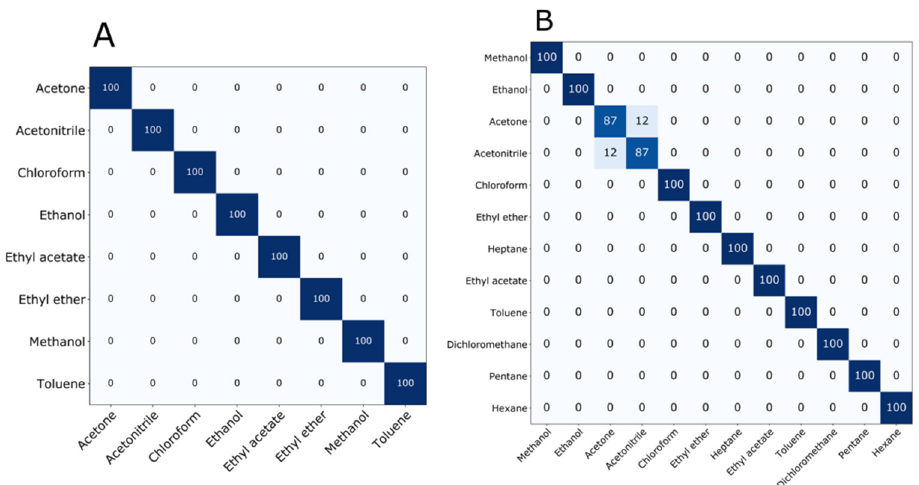
Figure 10. Confusion matrices of the Random SubSpace classifier applied in the predictions of VOCs ( A ) in set A sensors and ( B ) in set B sensors.